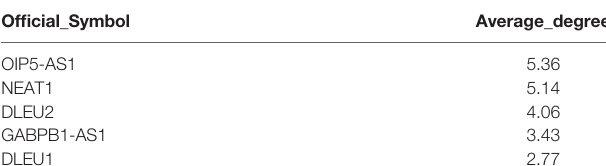
TABLE 2 | LncRNAs with top degree in early response subtype.